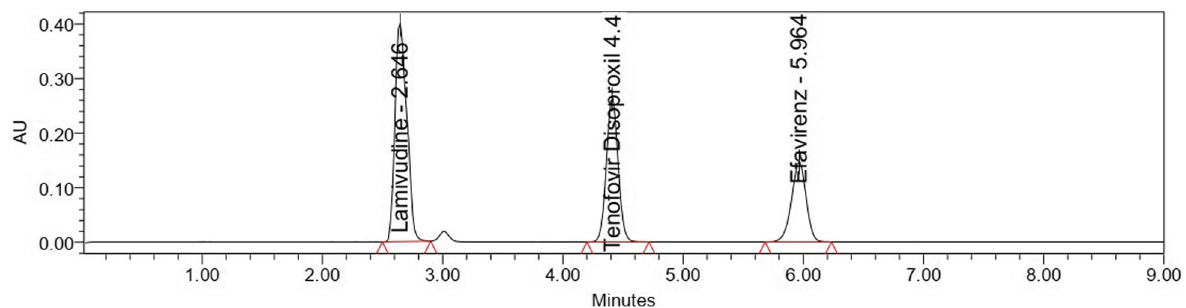
Fig. 2 Optimized chromatogram of the